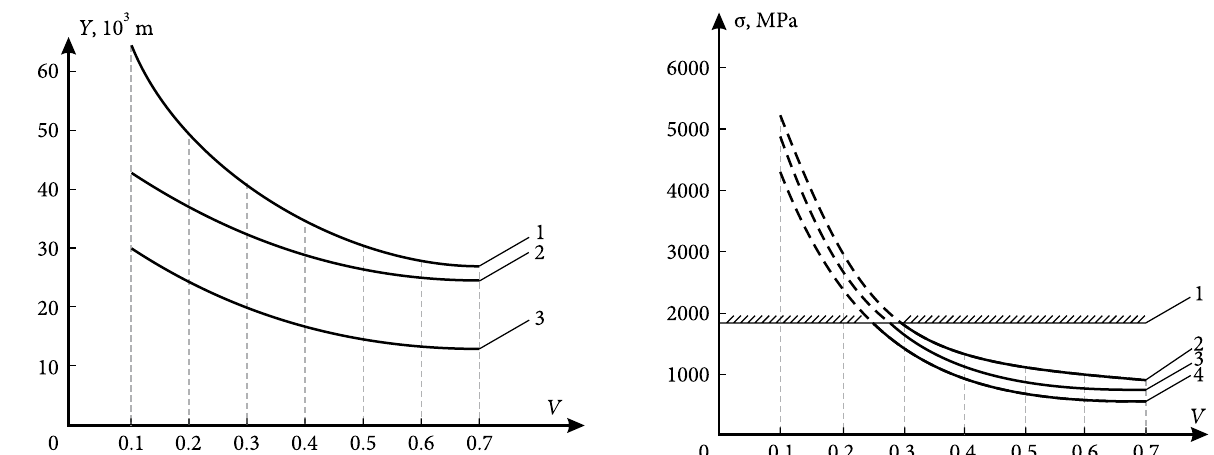
Moduli of elasticity are equal to 1.32 × 10 5 , 1.35 × 10 5 and 1.36 × 10 5 MPa, for the first, second and third variant of the hybrid composite cable, respectively. Max axial forc- es, which can be taken up by the cables, are equal to 1242,